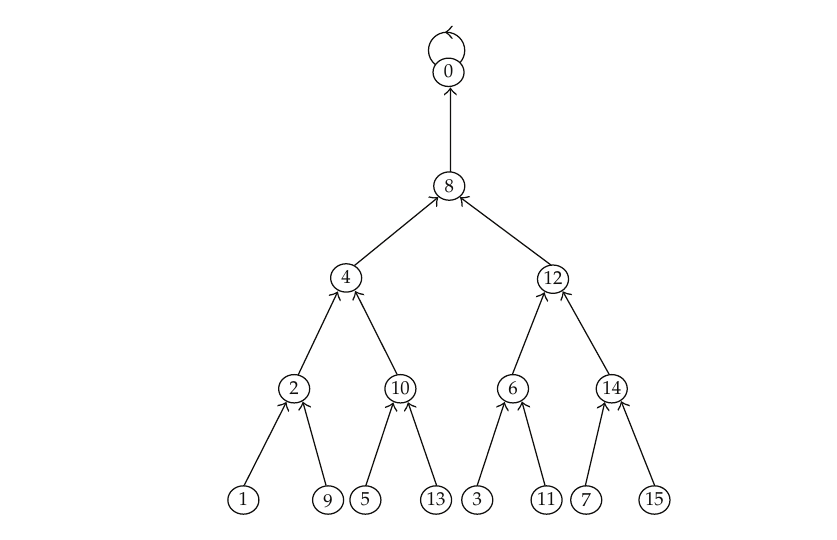
Figure 1: S.T.D. of (cid:4) 170 , 170 , 170 , 170 (cid:5) NB.